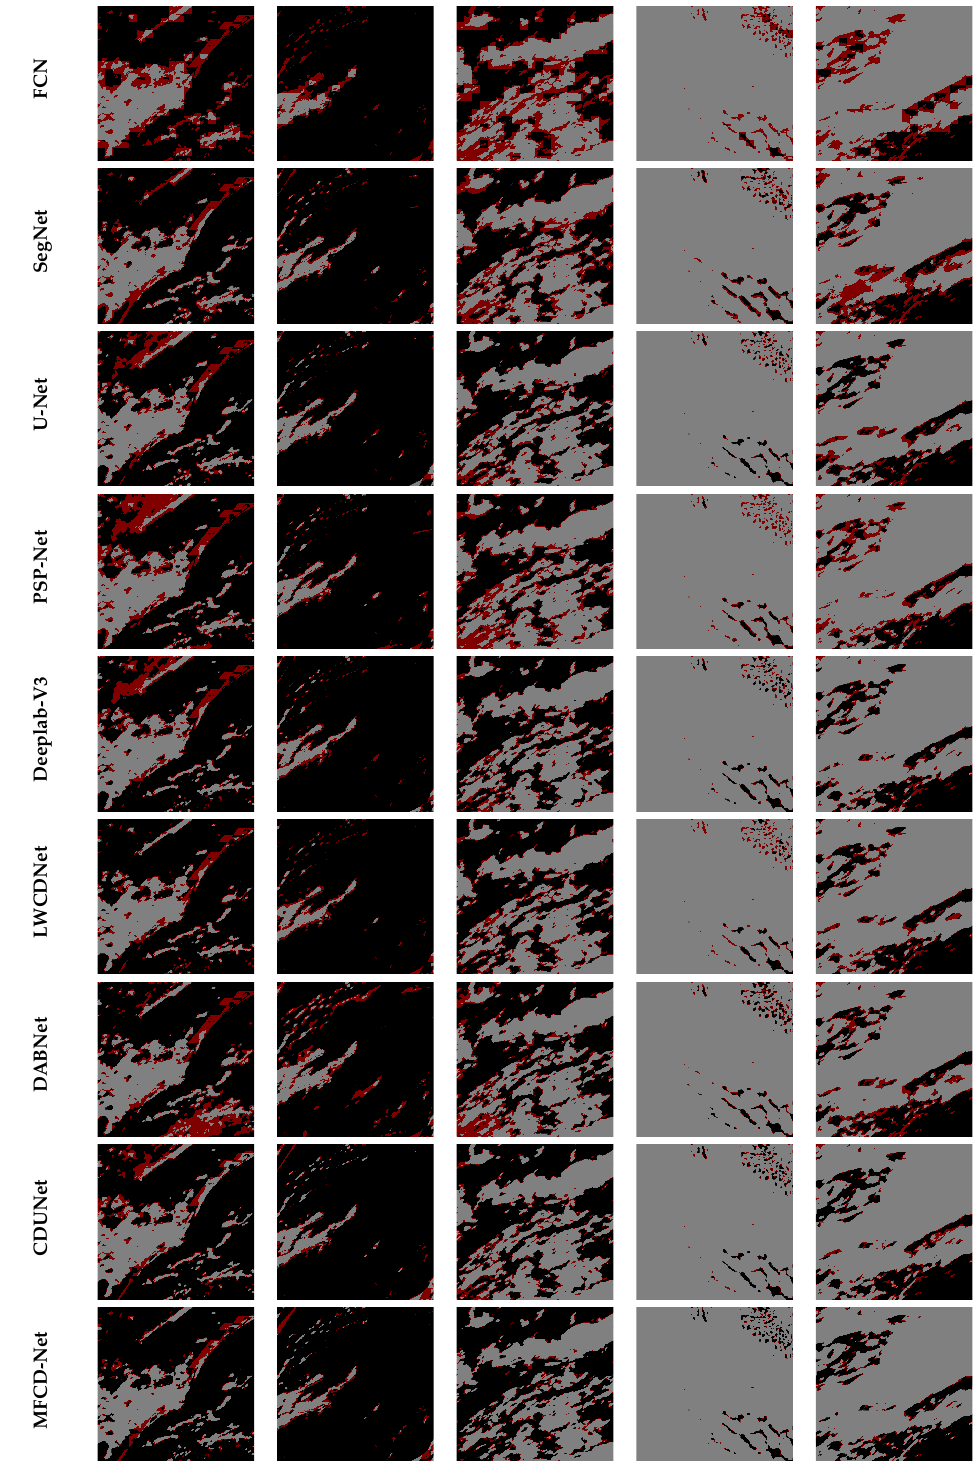
Figure 10. Experiment’s qualitative comparison results. The size of all images is 160 × 160. The thumbnails are the RGB pseudo-color composition of the third angle reflectance image of 670 nm band, 565 nm band, and 490 nm band. ( a – e ) are examples of five different situations; ( a ) is the sea–land mixed case, ( b ) is the thin cloud case in the ocean region, ( c ) is the land region, ( d ) is the thick cloud case, and ( e ) is the flare region. Gray represents cloud, black represents non-cloud, and red represents misclassification